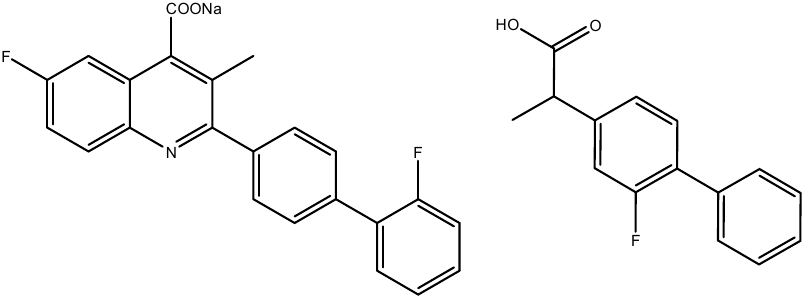
Figure 1. Structural formulas of Brequinar (left) and Flurbiprofen (right).